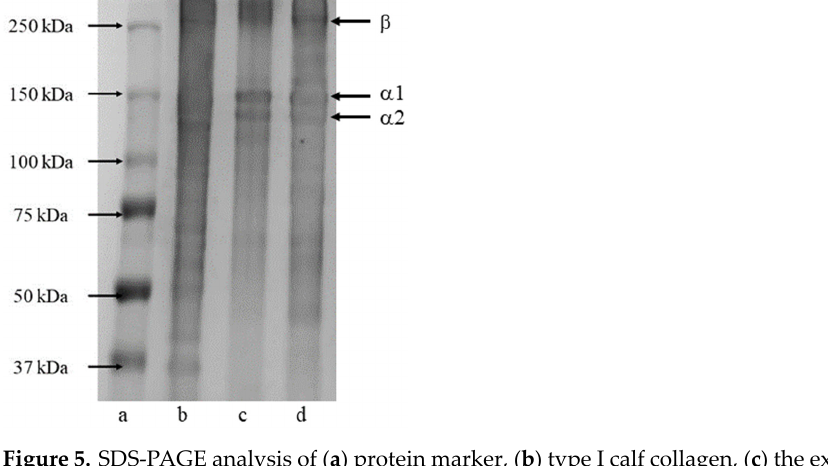
Figure 6. The soft white sponges from the skin and bone of striped catfish were observed with the naked eye. However, SEM revealed that dense and homogenous multilayered samples had formed, probably during the lyophilization process. The extracted colla- gen/gelatin structures were hexagonal at 50× magnification. At 200× magnification, the samples were sponge-like with porous structures. The structures were apparent, with a fibrous meshwork and loose and flaky orientation at further magnification. Our results are consistent with the SEM images of the extracted collagen from the skin of Nile tilapia [36]. The cross-sectional images revealed highly porous and homogenous structures with interconnected pores for both the skin and bone. The pores and the wrinkles on the surface of the products resulted from dehydration during the lyophilization step [32]. This rough surface creates a generous surface area, which results in a high absorption capability. Ac- cording to [33,37], a well-distributed pore structure is favorable for biomedical applica- tions, serving as matrices for absorption and cell proliferation. From our results, it can be said that the extracted products obtained from carbon dioxide-acidified water have the potential to be further developed as a material for wound dressing, hydrating agents, growth gene expression, and drug delivery [10,38] or grafted on chitosan-based polymer, which can be used for heavy metal removal from drinking water [14].